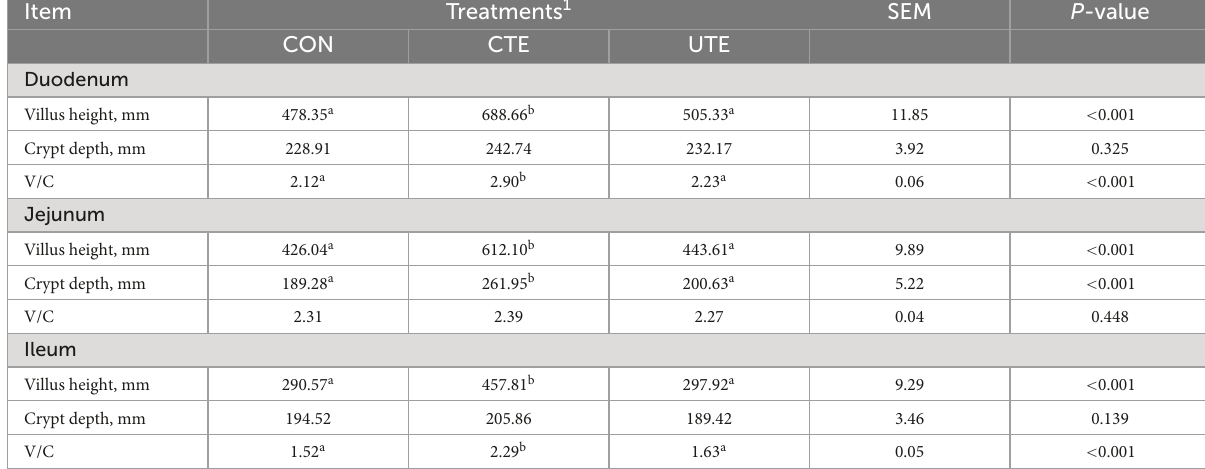
TABLE 6 Effects of coated and uncoated trace elements on intestinal